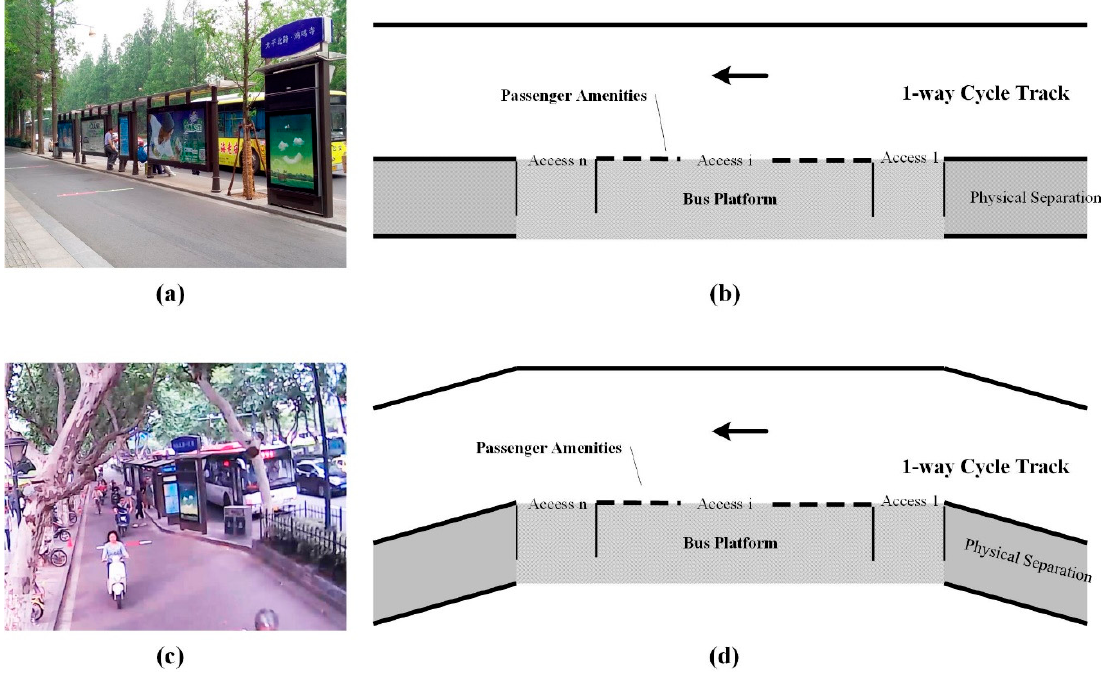
Figure 1. ( a ) Field picture (Jimingsi bus stop) for curbside bus stop with 1-way cycle track; ( b ) layout for curbside bus stop with 1-way cycle track; ( c ) field picture (Gulou bus stop) for bus bay with 1-way cycle track; ( d ) layout for bus bay with 1-way cycle track.